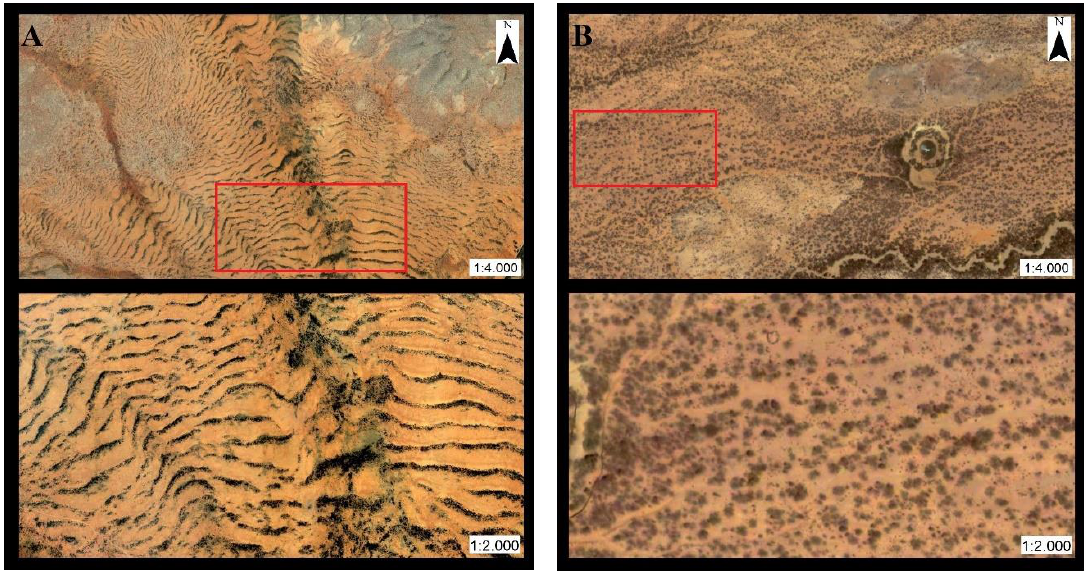
Figure 1. Tiger bush pattern ( A ), Somalia 2010 (7°46’51.15” N, 47°55’38.56” E); and leopard bush pattern ( B ), La Guajira 2007 (12°8’6.54” N, 72°7’25.92” W). QuickBird—ArcGIS Online data.